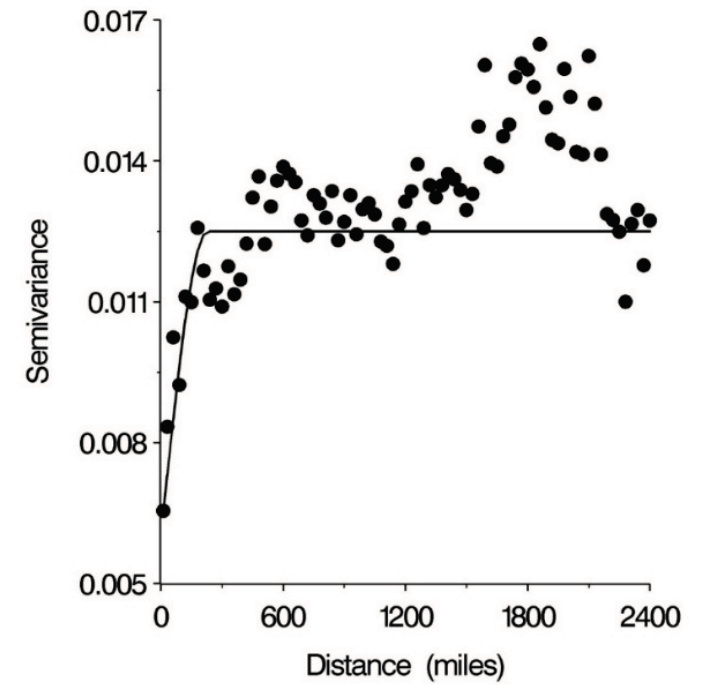
Figure 2. Spatial variogram used to determine range, scale and nugget used in spherical covariance matrix. The parameters used in the model and as shown in the solid line on the graph were nugget 0.006, range 230 miles and scale